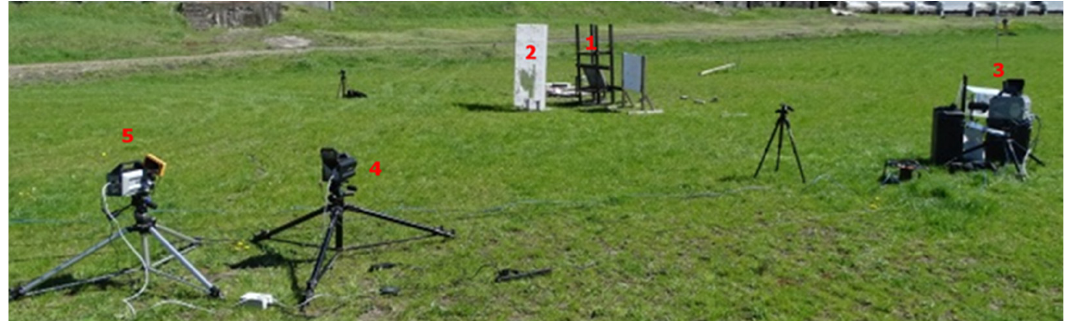
Figure 6. Stand for testing the ignition capability of solid flammable substances together with ricochet temperature measurement. 1, stand with a plate; 2, ricochet shield; 3, Photron Fastcam SA-Z 2100K high ‐ speed camera; 4, FLIR X6580sc thermal camera; 5, FLIR A6901scSLS thermal camera.